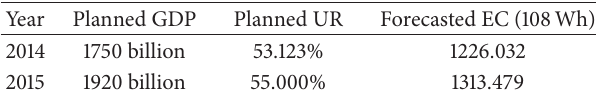
Table 5: Predicators and forecast results of EC in 2014 and